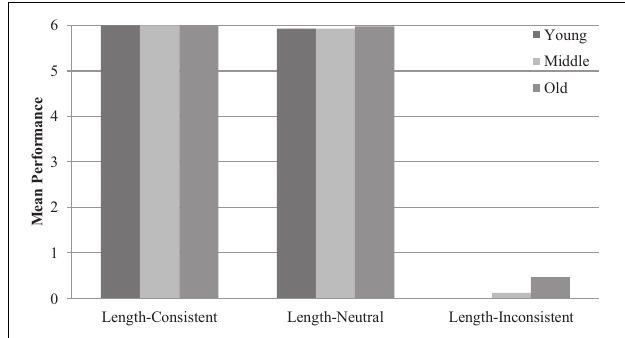
FIGURE 2 | Mean pre-test performance by age group and task